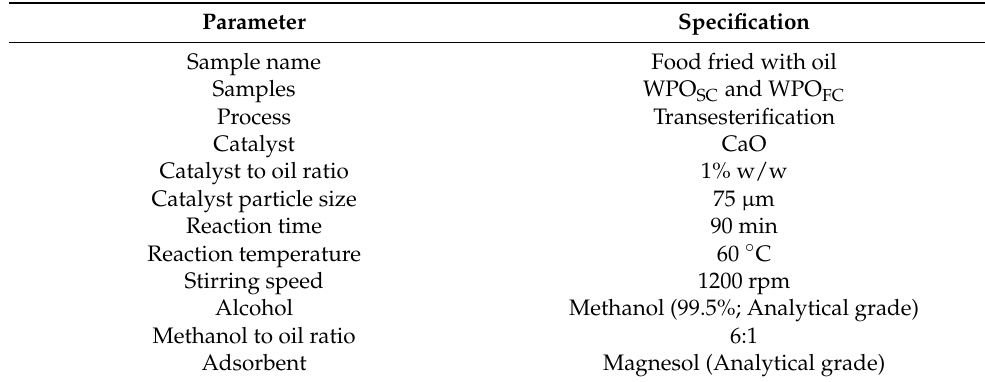
Table 2. Summary of the WPOME production parameters.